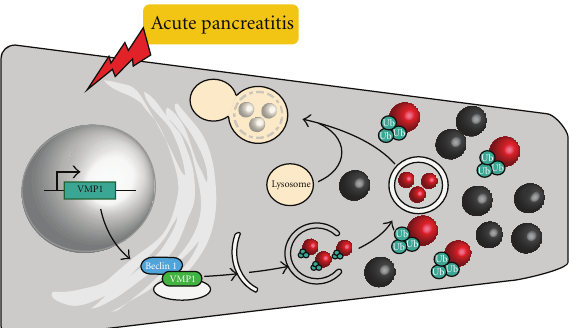
Figure 1: Upon acute pancreatitis, the acinar cell activates Vmp1 gene expression and triggers the autophagic degradation of those zymogen granules activated during the disease (in red) avowing the intracellular spreading of activated digestive enzymes. Altered zymogen granules are recognized by ubiquitination. Zymophagy is a novel inducible and selective form of autophagy, mediated by VMP1, which functionally links the autophagy pathway with the ubiquitin machinery to trigger a protective response to